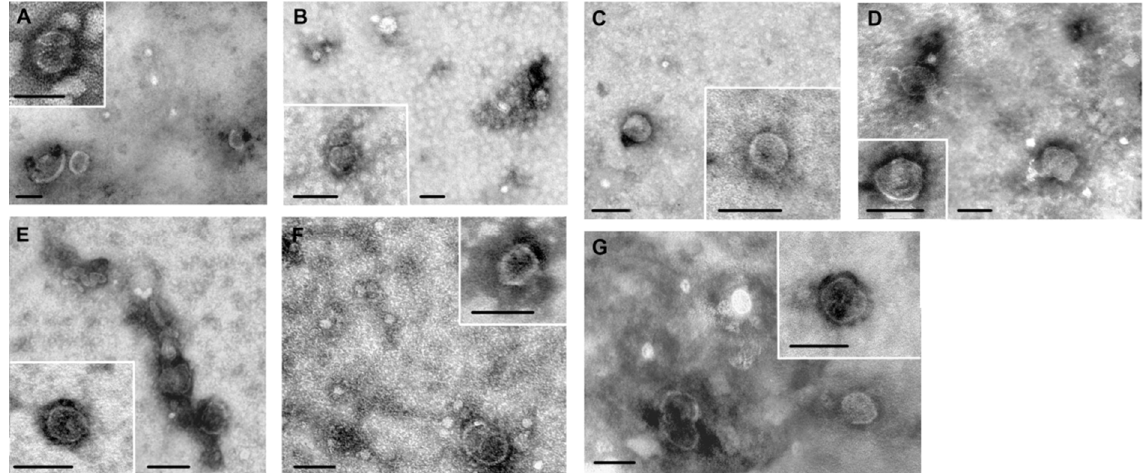
Figure 1. Total view of exosomes preparation obtained from: ( A ) blood plasma of HFs; ( B ) blood plasma of BBTPs; ( C ) blood plasma of BCPs; ( D ) blood plasma of patient with BOTPs; ( E ) ascites of patient with BOTPs; ( F ) blood plasma of OCPs; ( G ) ascites of OCPs. Scale bars correspond to 100 nm. Electron microscopy, negative staining by phosphotungstate acid.